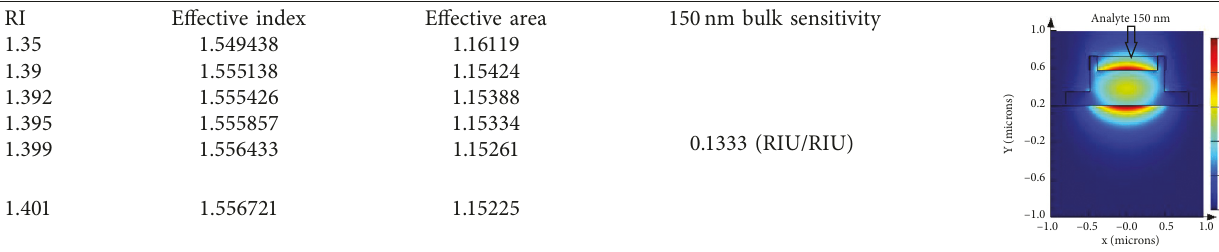
Table 5: Analysis of bulk sensitivity of rib-slot waveguide with 150nm analyte